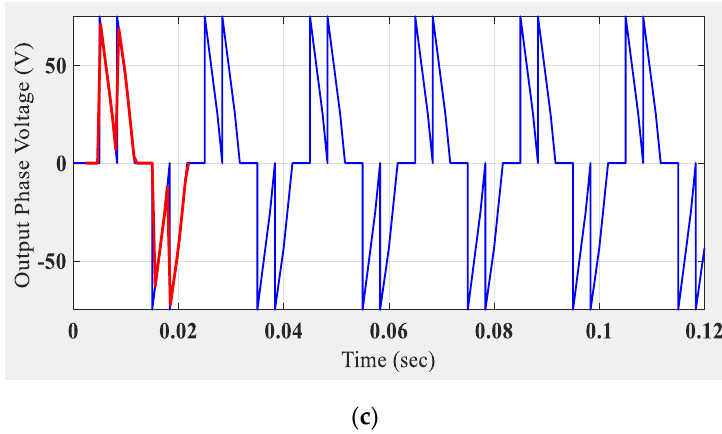
Figure 9. The output voltage waveform of one phase of a three-phase AC voltage controller with a firing delay of ( a ) 60°, ( b ) 90°, and ( c ) 90° with appropriate wave shifting. Table 6. Harmonic coefficients of one phase of a three-phase AC voltage controller with a 60 ° firing delay. Harmonic Order ( n ) Harmonic Frequency (Hz)